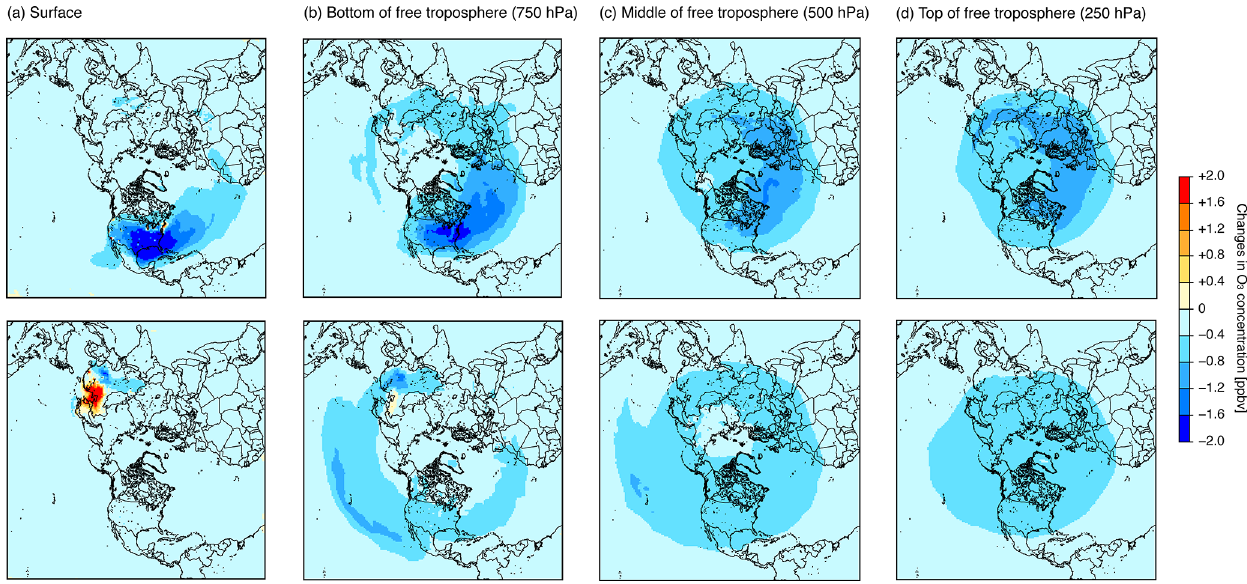
Figure 9. Perspective of changes in O 3 concentration resulting from estimated 2010–2015 emission changes over (top panels) the US and (bottom panels) east Asia at the (a) surface, (b) bottom of free troposphere (750hPa), (c) middle of free troposphere (500hPa), and (d) top of free troposphere (250hPa).